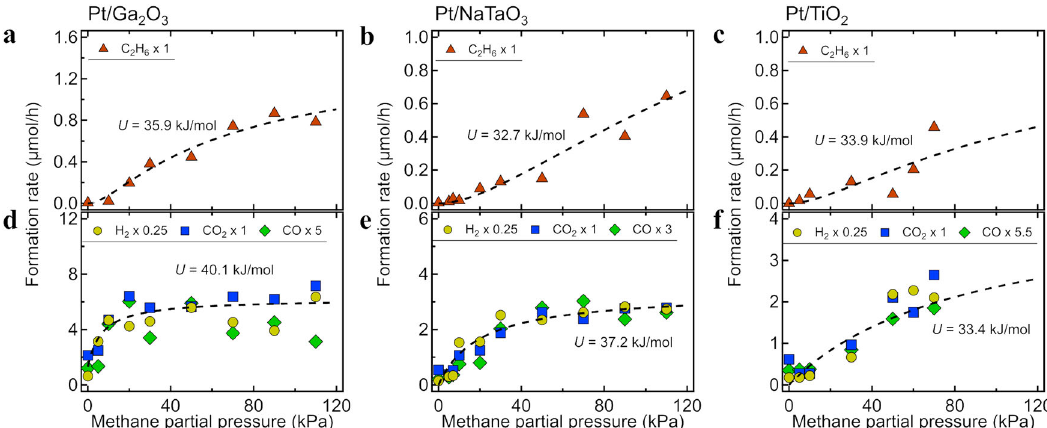
Fig. 4 P CH4 pro fi les of photocatalytic methane conversion with water. Formation rates of H 2, CO 2 , CO, and C 2 H 6 for the a , d Pt/Ga 2 O 3 , b , e Pt/NaTaO 3 , and c , f Pt/TiO 2 photocatalysts under UV irradiation as functions of methane partial pressure at a H 2 O partial pressure of 2 kPa. The dashed lines are the curve fi tting results following the equation: [ KP CH /(1 þ KP CH )] n , where n = 2 for C 2 H 6 and n = 1 for CO and CO 2 4 4